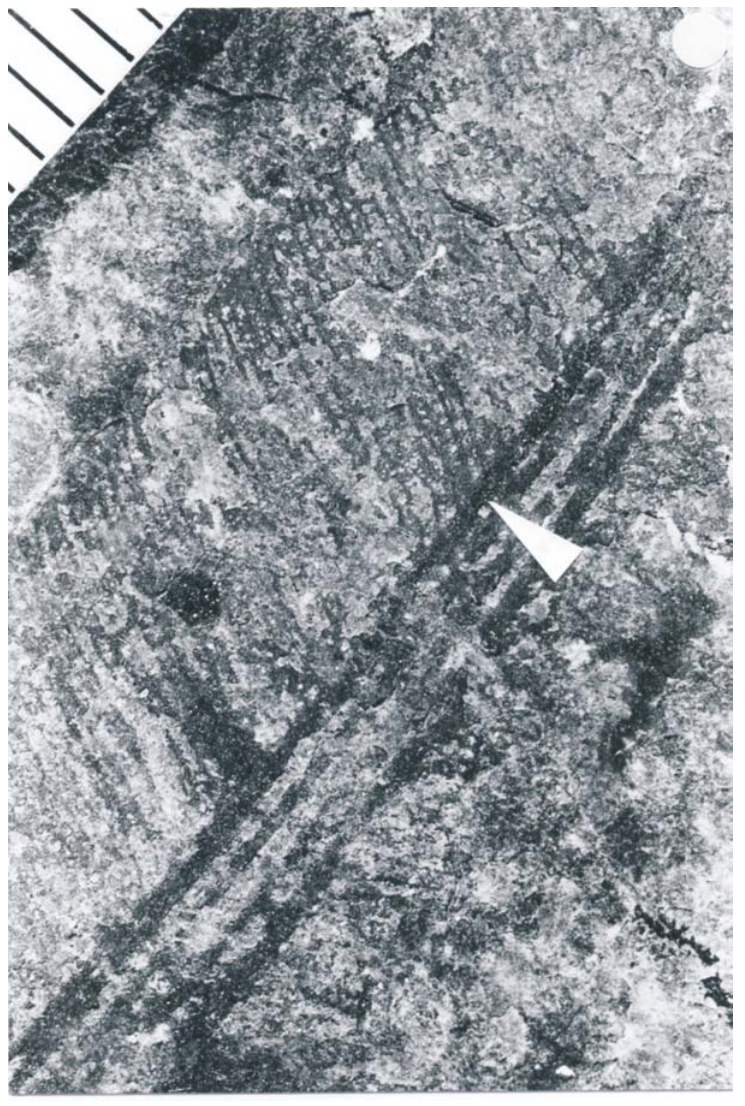
Fig. 4 – Part of the leaf illustrated in Fig. 2 (B) [MP-Pb 3577A] enlarged to show details of taeniopteroid venation (arrow). Scale bars in